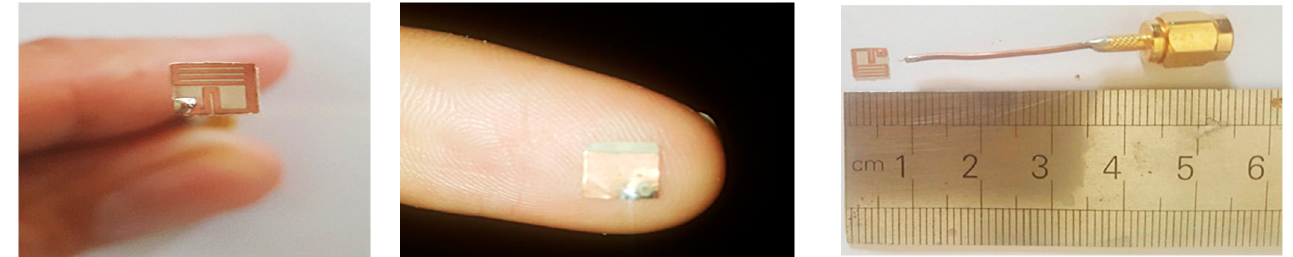
Figure 15. Photos of the prototypes fabricated antenna.